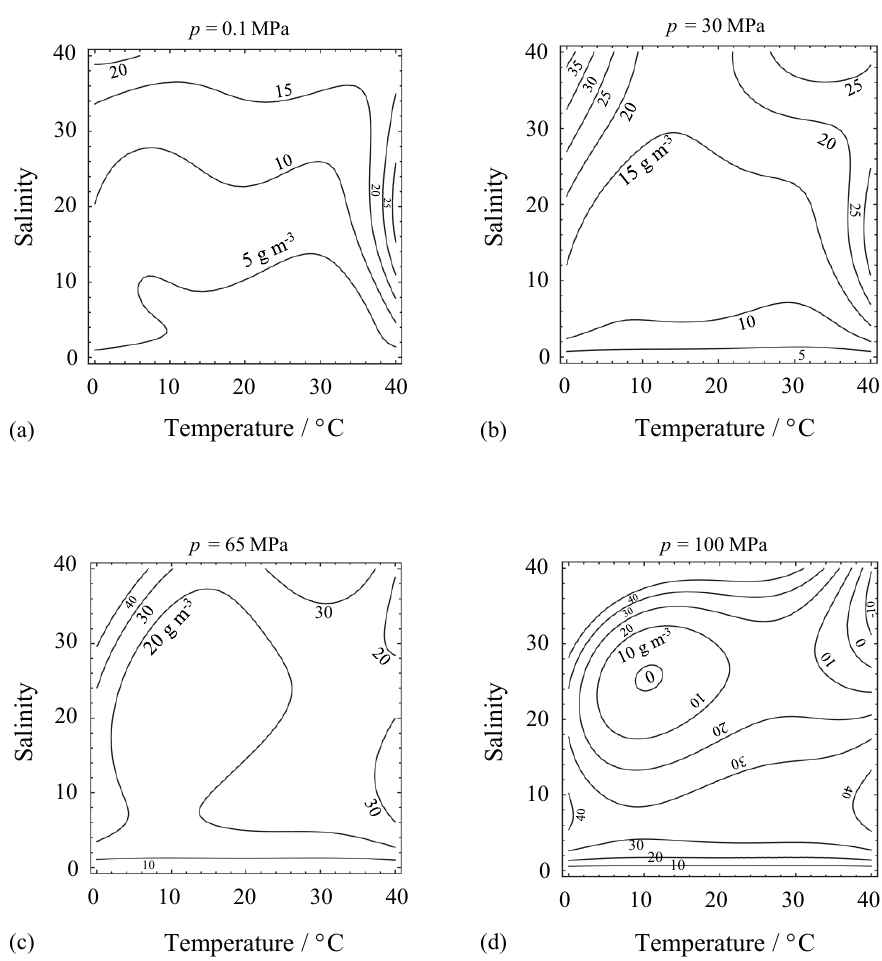
Figure 13. Density deviation of TEOS-10 from the density–salinity relation (i.e. TEOS-10 minus DSR) for degassed seawater (a) at at- mospheric pressure, (b) at 30MPa, (c) at 65MPa, and (d) at 100MPa. The uncertainties in the deviation are 8, 26, 26, and 33gm − 3 . The deviations only exceed these uncertainties significantly at atmospheric